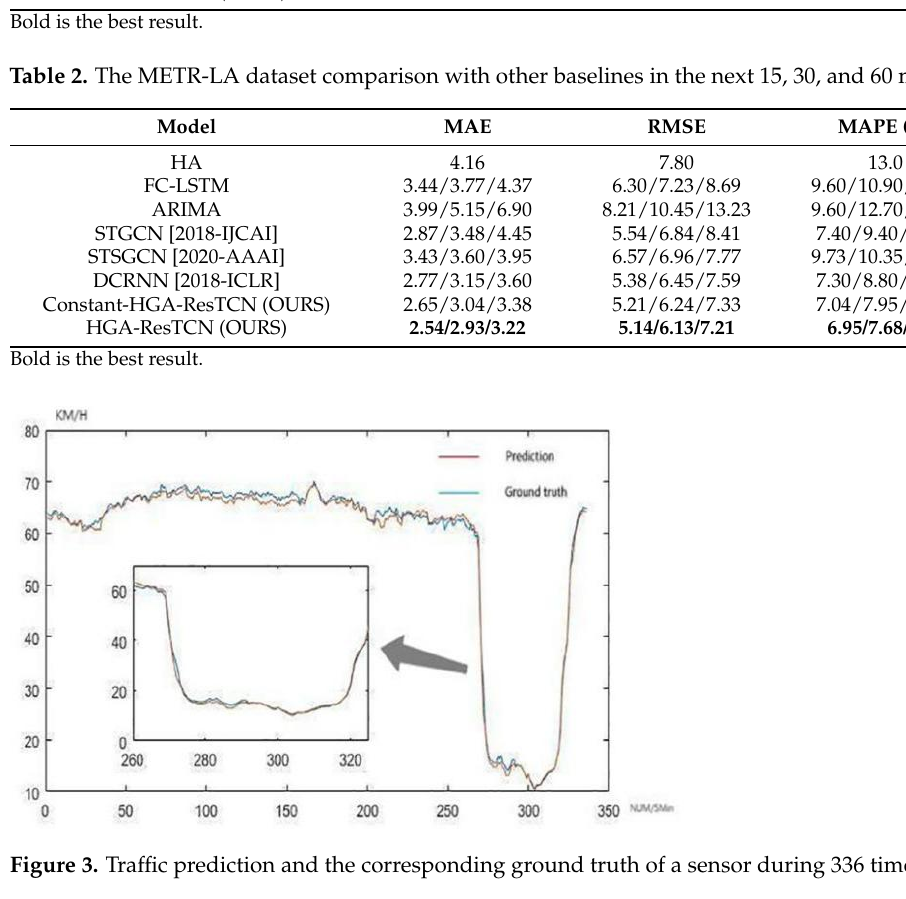
Table 1. The PEMS-BAY dataset comparison with other baselines in the next 15, 30 and 60 min.